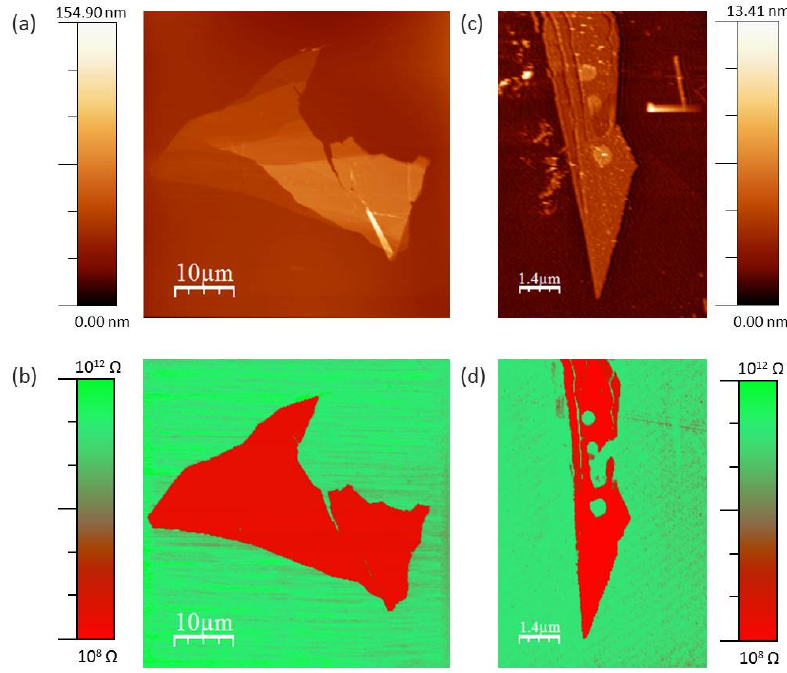
Figure 6. ( a ) AFM topography image measured in contact mode of a TaS 2 flake; ( b ) CT-AFM resistance mapping of the same flake; ( c ) AFM topography image of TaS 2 thin flakes; ( d ) CT-AFM resistance mapping of the patterned flake shown in ( c ).